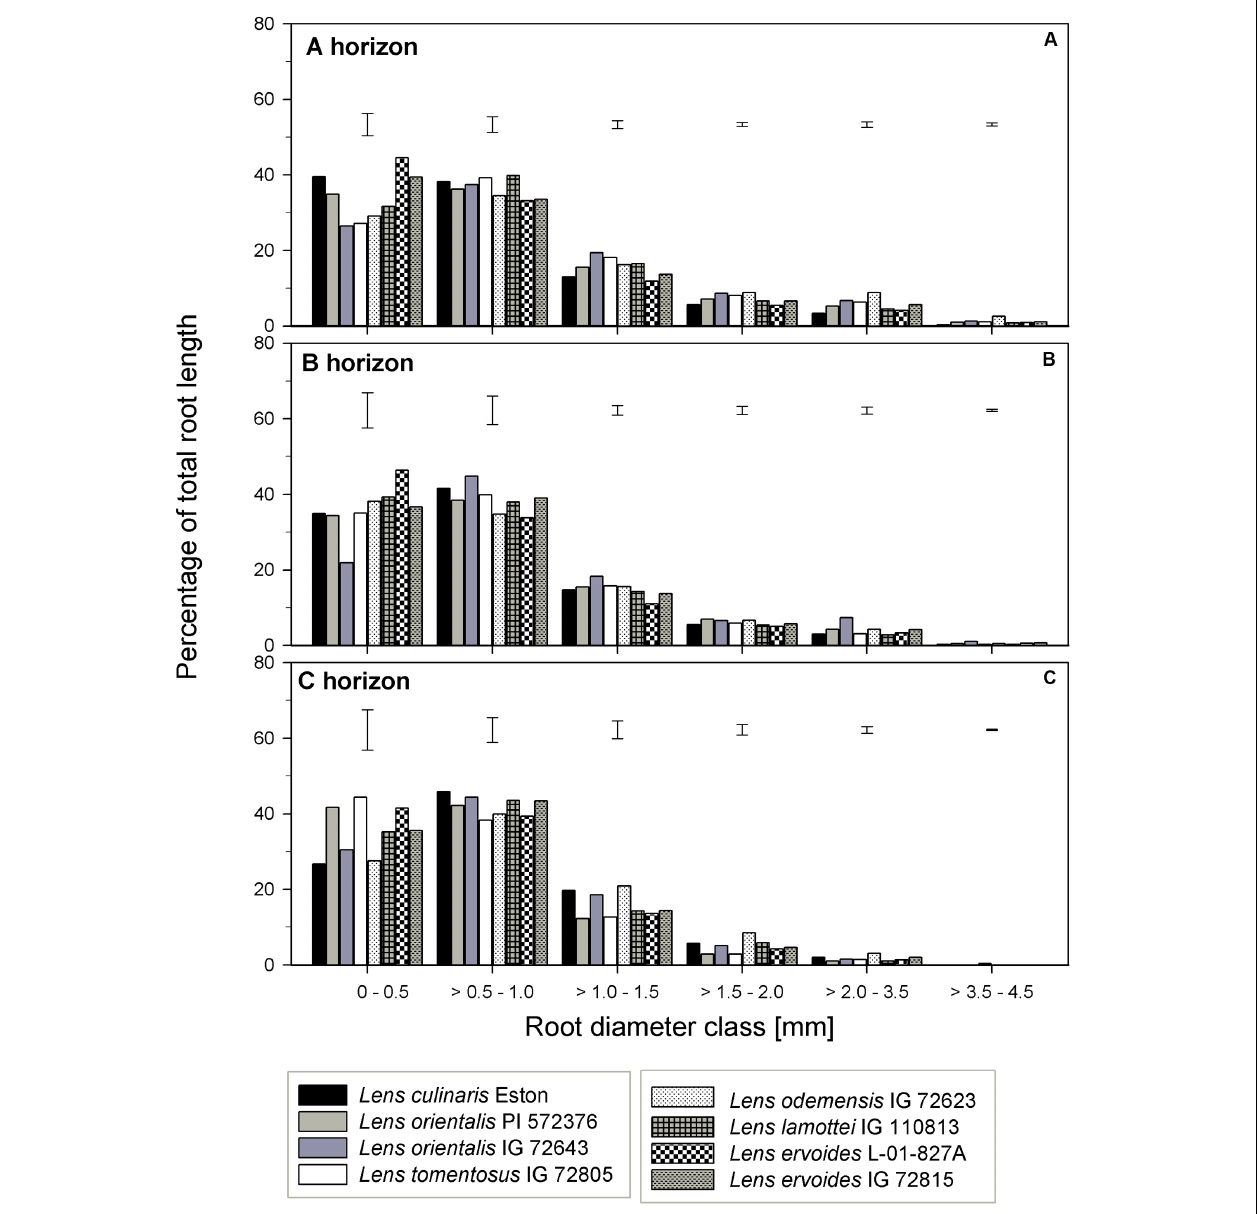
FIGURE 4 | Percentage of total root length distribution across six root diameter classes assessed in three soil horizons for seven wild lentil genotypes in comparison to cultivated lentil ( Lens culinaris Eston. The line bars are LSD values at P < 0.05 for comparison of genotypes within a diameter class. (A) A horizon; (B) B horizon; (C) C